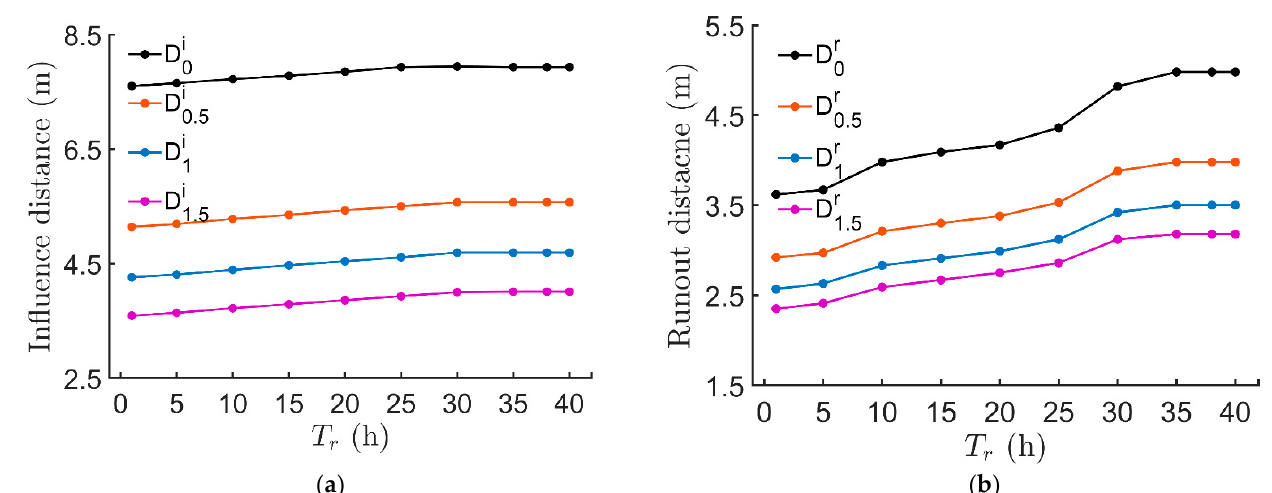
Figure 18. Variations in influence distance and runout with different rainfall duration: ( a ) different influence distances in uniform slopes; ( b ) different runout distances in uniform slopes.